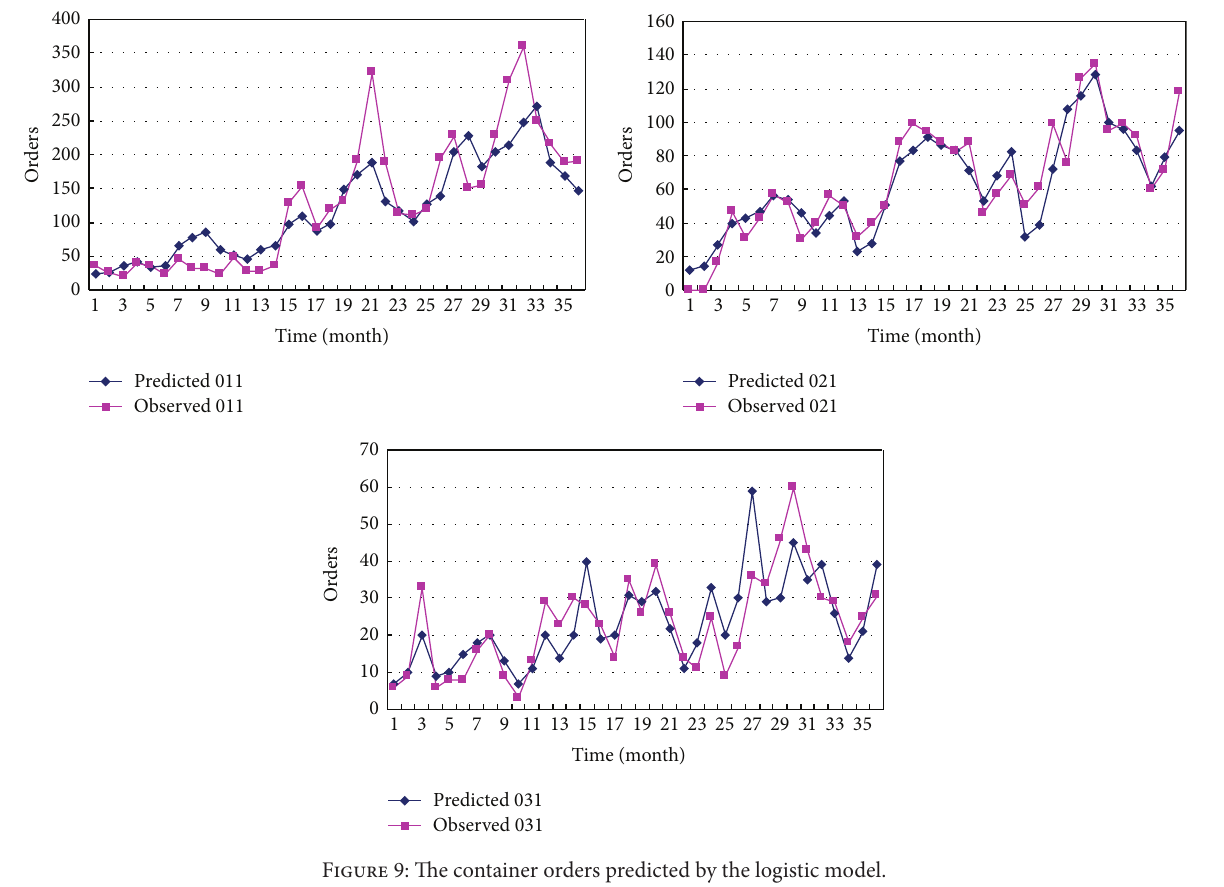
Figure 9: The container orders predicted by the logistic model.